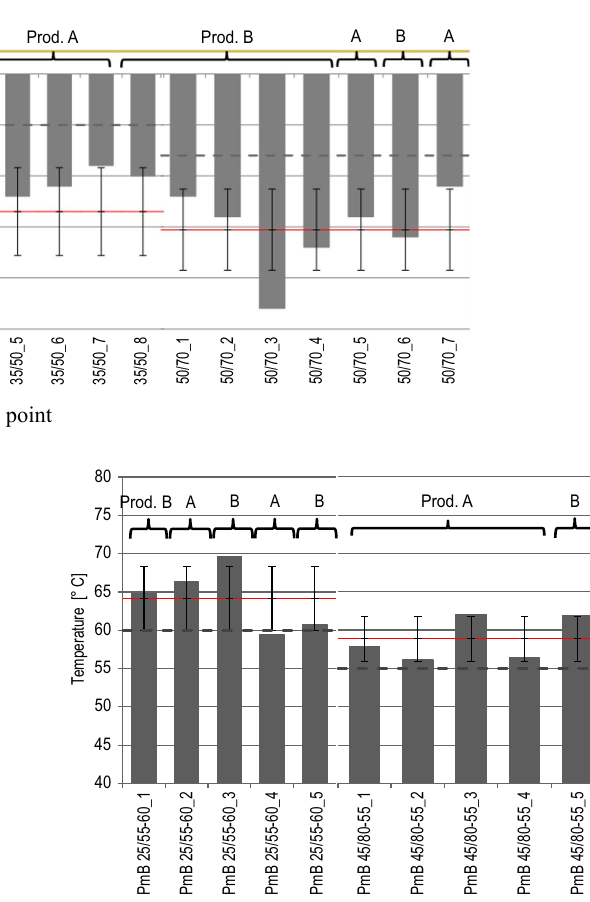
Fig. 4. Polymer modified bitumen penetration at 25 °C Fig. 5. Polymer modified bitumen softening